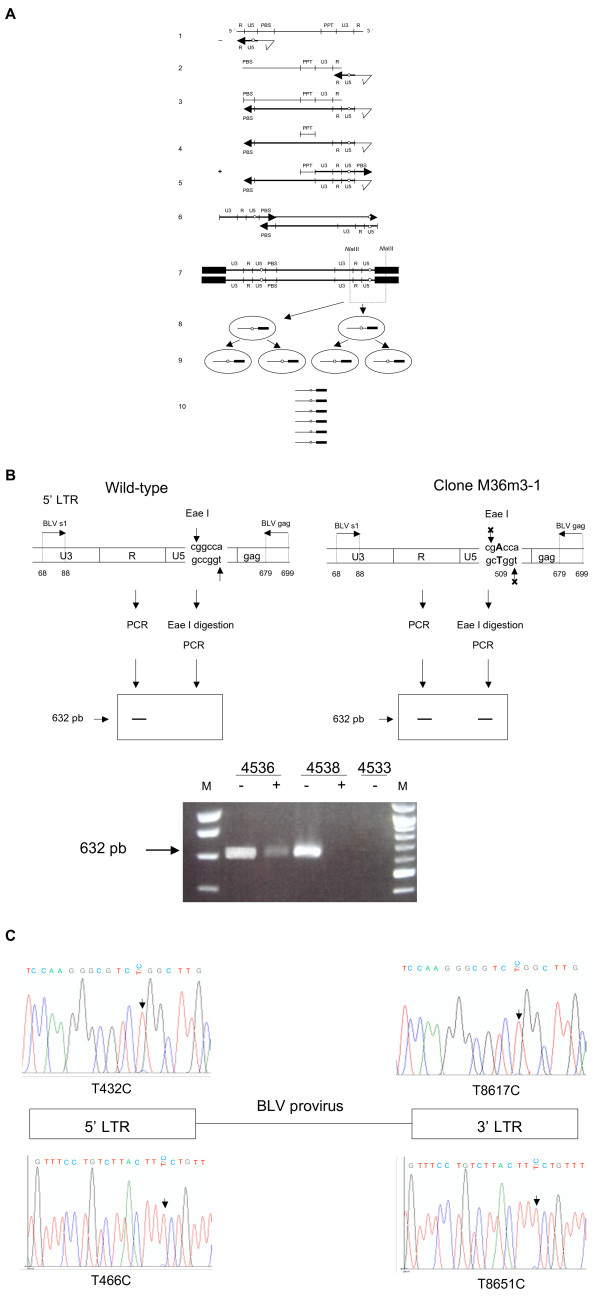
RT-associated mutations frequently occur during BLV minus strand synthesis. A Generation of U5 substitution during minus strand synthesis. RNA is represented as a thin line whereas DNA is represented as thick lines. The first 6 horizontal lines represent the synthesis of the provirus. Line 7 represents the integrated provirus flanked with its two integration sites represented as black boxes. NlaIII restriction sites are represented on both the provirus and the 3' cellular flanking sequence. Lines 8 and 9 represent the first two mitoses of the infected cells harboring the integrated provirus. For each cell, the RU5 sequence and the 3' flanking sequence encompassed by the 2 NlaIII restriction sites, i.e., the sequences obtained after inverse PCR, are represented. Line 10 represents the sequences obtained after inverse PCR, cloning and sequencing. The open circle represents a RT-associated mutation that has occurred during the synthesis of the 5' RU5 minus strand. As shown in lines 1 to 6, this substitution appears to be harbored by both strands of the two LTRs of the integrated provirus. Accordingly, all infected cells from the corresponding clone (identified by their common integration site) harbor a provirus with the same substitution (see lines 8 and 9). As a consequence, all sequences from this clone obtained after inverse PCR harbor the same mutation at the same position. B PCR detection of the G511A U5 substitution along the 5' LTR. Top: 5' BLV LTR from the wild-type (left) and from clone M36m3-1 (right) carrying the putative G511A substitution having occurred during minus strand synthesis, thereby generating the G8696A substitution identified by sequencing IPCR product derived from the sample harvested in animal 4536 three days before seroconversion. In the absence of digestion, specific 5' LTR PCR amplifies a fragment of 632 bp. EaeI digestion of the wild-type sequence abolishes this signal while incubation with EaeI has no effect on the sequence carrying the G511A mutation, leading to the detection of the 632 bp fragment. Samples studied in the presence (+) or in the absence (-) of EaeI digestion derived from BLV infected animals 4536 and 4538, both harvested 3 days before seroconversion, and from the uninfected control animal 4533. C Detection of the T8617C and T8651C substitutions in their corresponding positions along the 5' LTR. Each LTR was specifically amplified by PCR and substitutions were detected by direct sequencing of PCR product, as detailed in the experimental procedures.